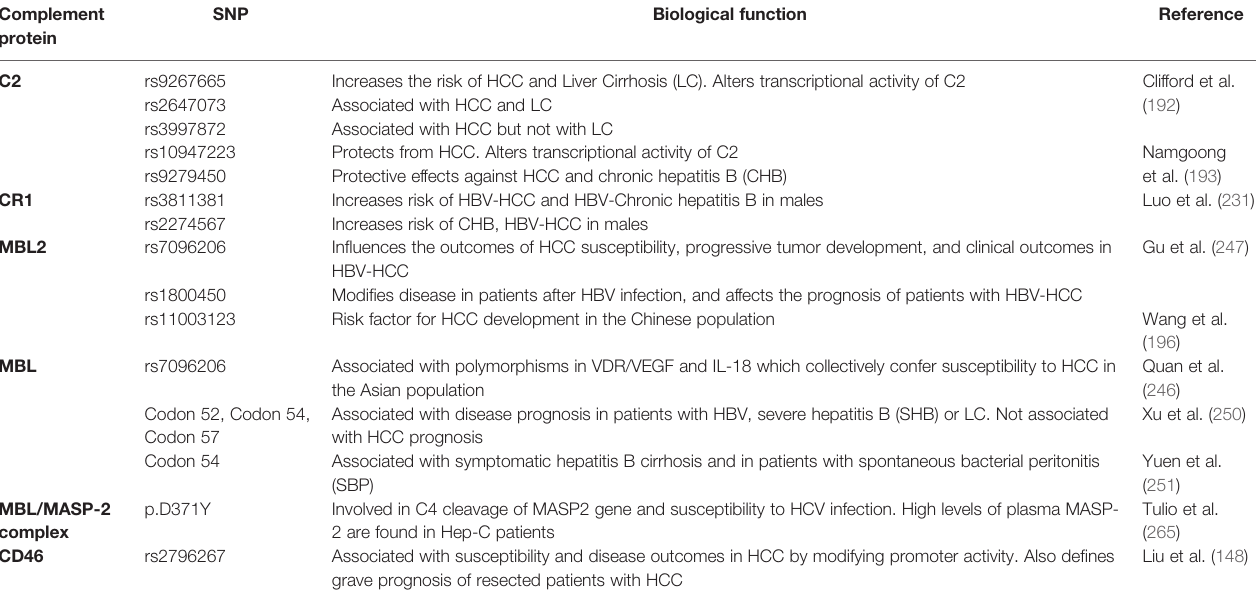
TABLE 2 | Summary of complement protein single nucleotide polymorphisms (SNPs) in hepatocellular carcinoma (HCC). Complement protein